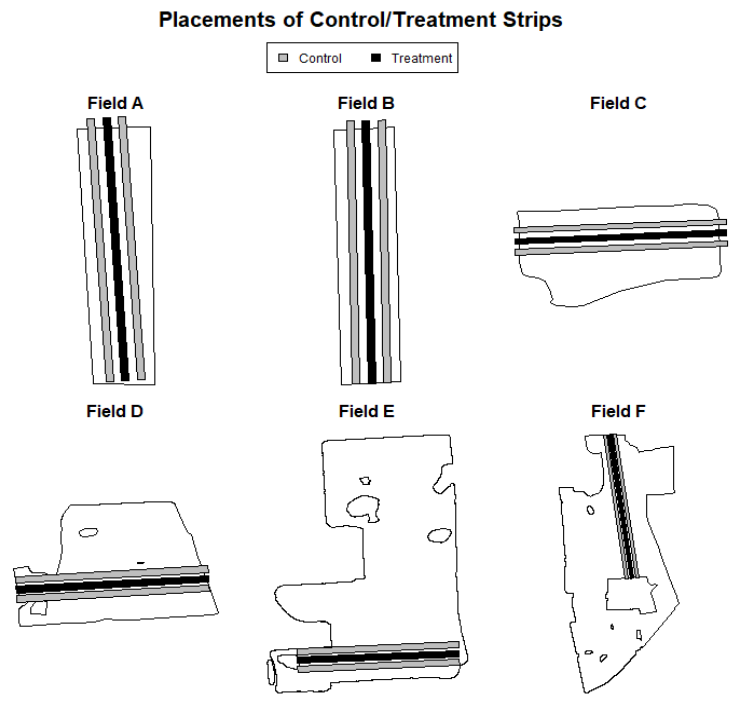
Figure 2. Placements of nitrogen treatment strips (black) and control strips (grey) for three fields on a cash grain operation (Fields A, B, C) harvested for corn grain and three fields on a dairy farm harvested for silage (Fields D, E, F).